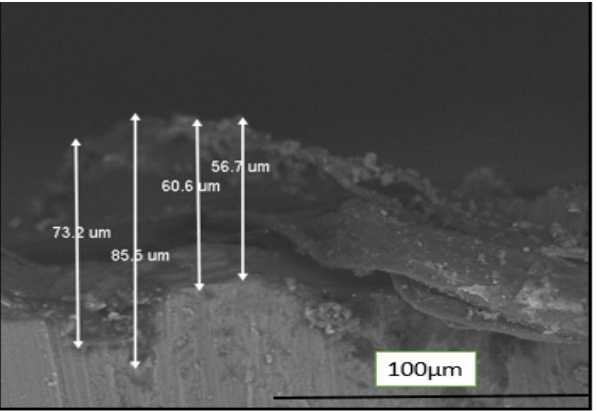
Figure 3. Observation of the thickness of the chitosan inhibitor layer at magnification (1000x) with an EPD time of 20 min on metal AA5052.